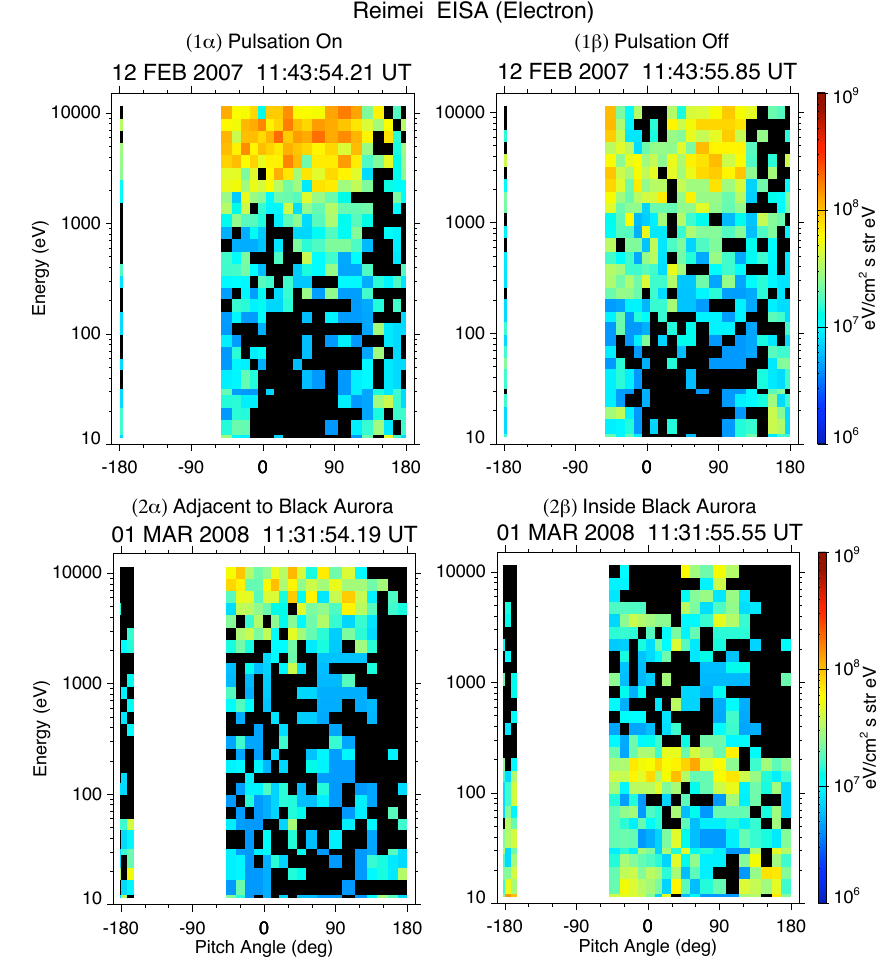
Fig. 6. Electron differential energy flux as a function of energy and pitch angle for a pulsating aurora case (1) and a stable black aurora case (2), both in the bright ( α ) and dark ( β ) regions of the